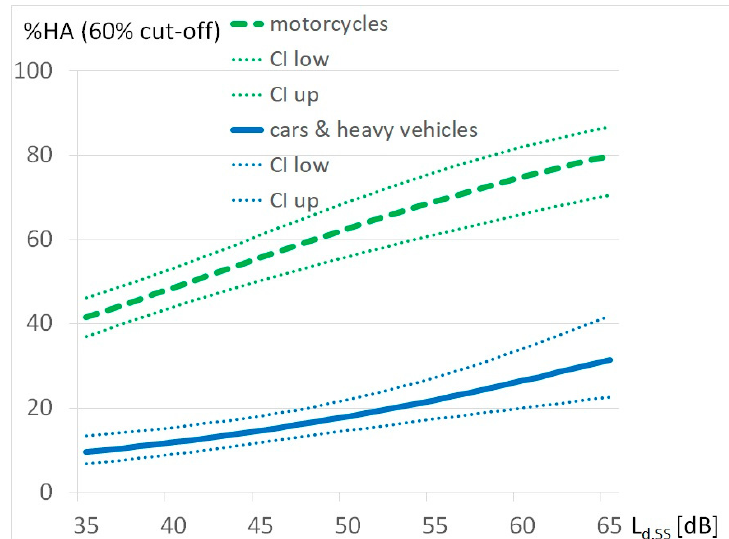
Figure 4. Exposure ‐ response relationship %HA 60 for motorcycles and other vehicles (cars and heavy vehicles) adjusted by noise sensitivity and attitude to motorcycles by noise exposure during daytime on summer Sundays L d,SS .